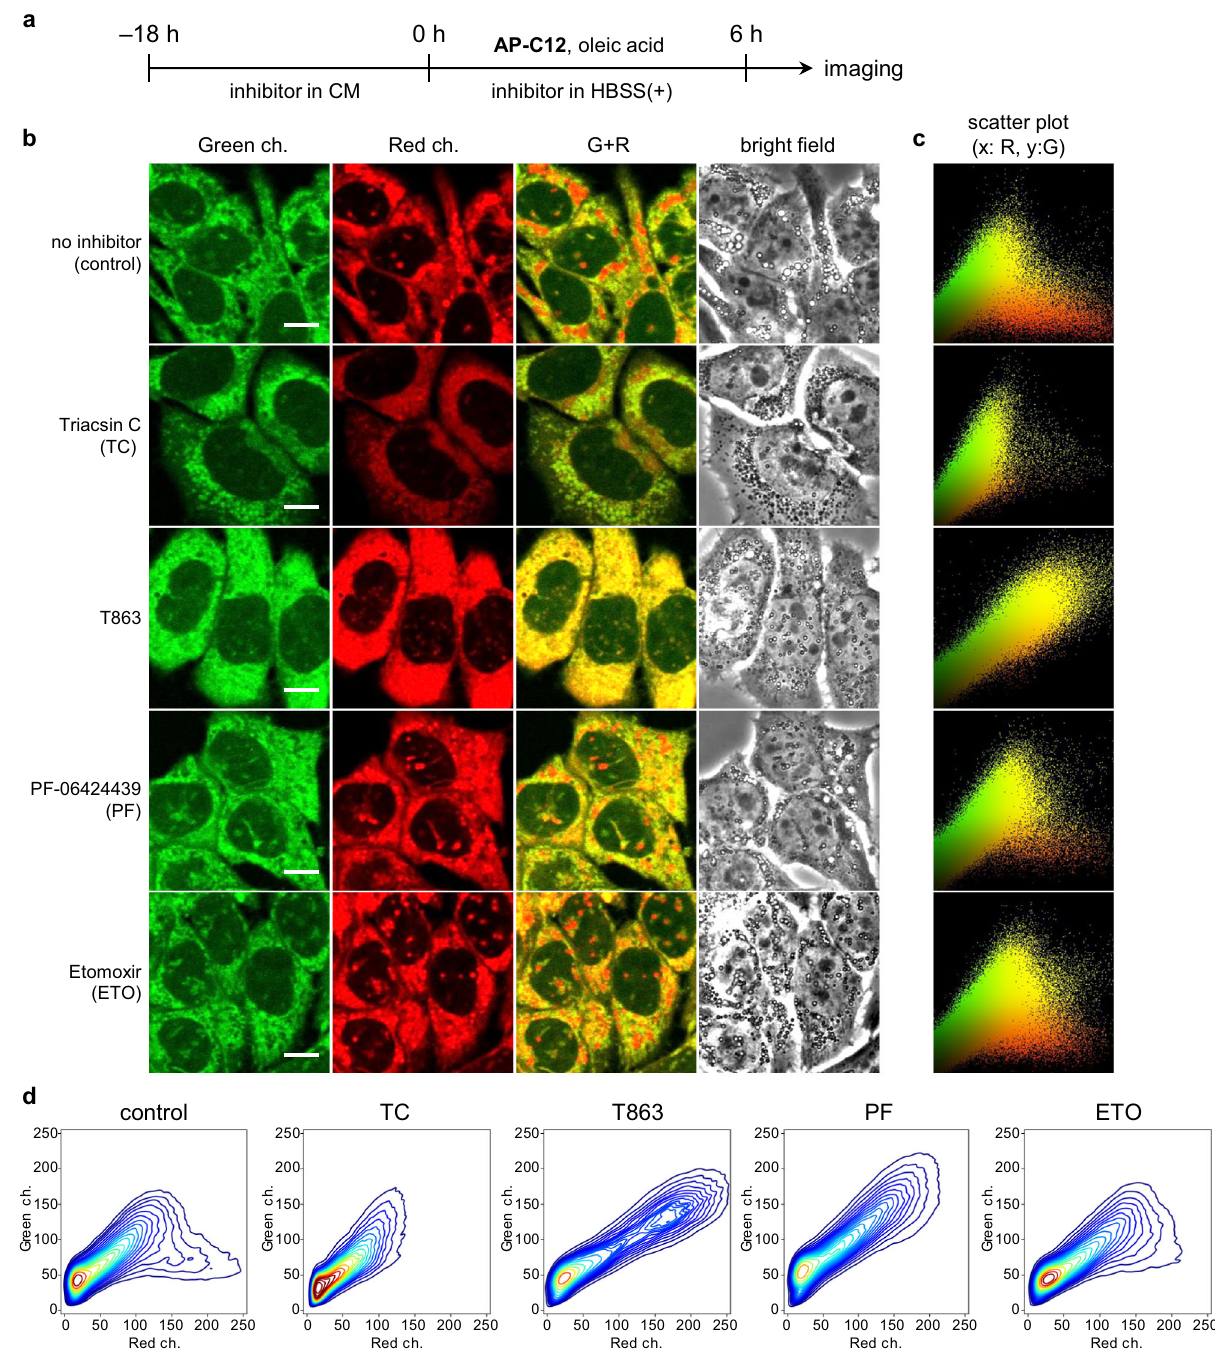
Fig. 3 Distribution analysis of AP-C12 metabolites in HepG2 cells treated with fatty-acid-metabolism inhibitors under nutrition-starvation conditions. a Scheme of the preparation process for imaging: HepG2 cells were incubated in complete medium (CM) 18 h before the addition of each inhibitor. The medium was then replaced with HBSS containing 5 µ M AP-C12, 0.5 mM oleic acid, and the indicated inhibitor. The cells were incubated for 6 h and then imaged. Inhibitors: triacsin C (TC), 5 µ M; T863, 20 µ M; PF-06424439 (PF), 10 µ M; etomoxir (ETO), 10 µ M. b Confocal images of HepG2 cells treated with the various inhibitors. From left to right: the images recorded in the green and red channels, the merged images of the two channels, and the bright- fi eld images. The experiment was independently repeated twice with similar results. Scale bar, 10 µ m. c Scatter plots of the signal intensities of the red (x axis) and green (y axis) channels observed in panel b . d Two-dimensional kernel density estimation (2D-KDE) contour plots for the distribution of the signal intensities corresponding to panel b